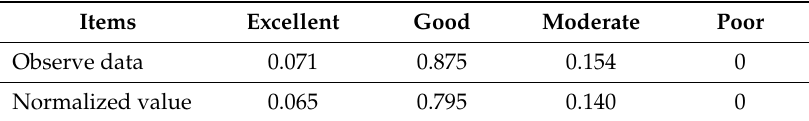
Table 6. Cable tension original value and normalized